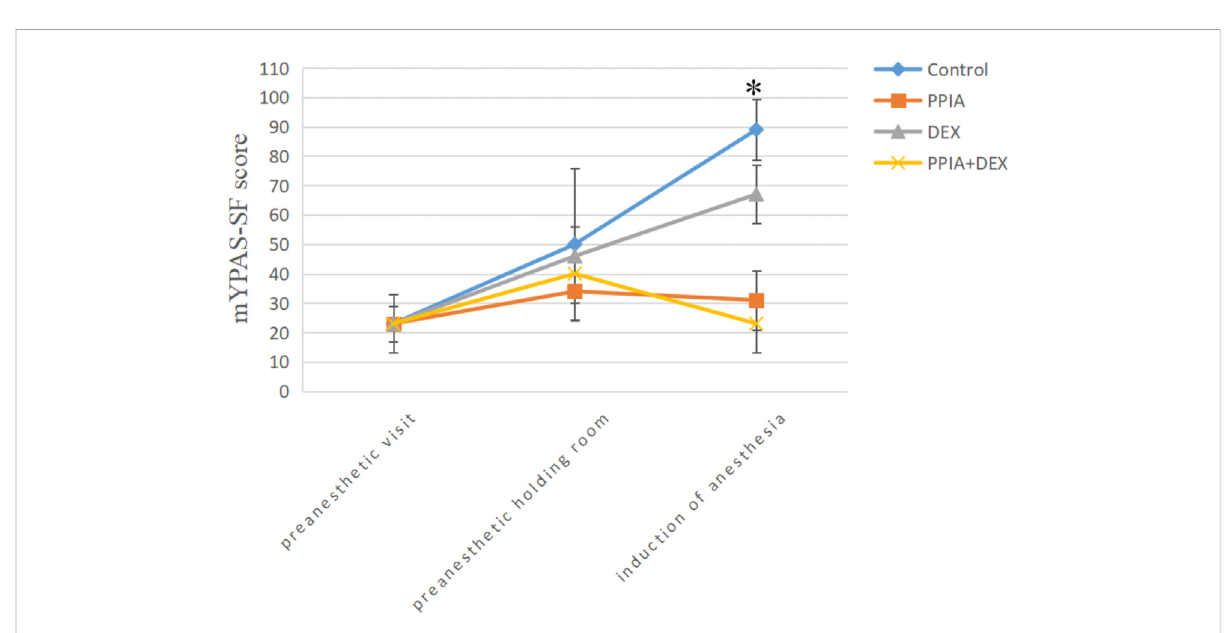
FIGURE 3 Median mYPAS-SF scores for children over time by group. * p < 0.05 between group analysis. mYPAS-SF (modi fi ed Yale Preoperative Anxiety Scale-Short Form); PPIA, parental presence at induction of anesthesia. DEX, intranasal